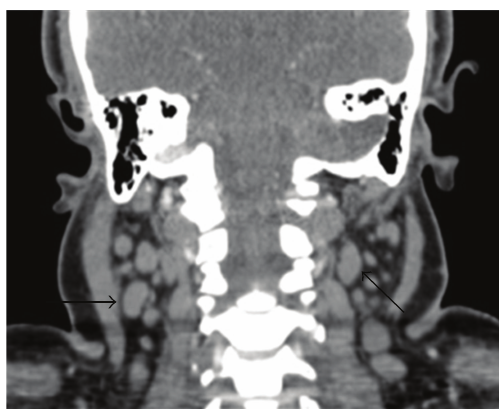
Figure 1: CT neck with contrast revealed di ff use cervical adenopa- thy (arrows demonstrate lymphadenopathy).